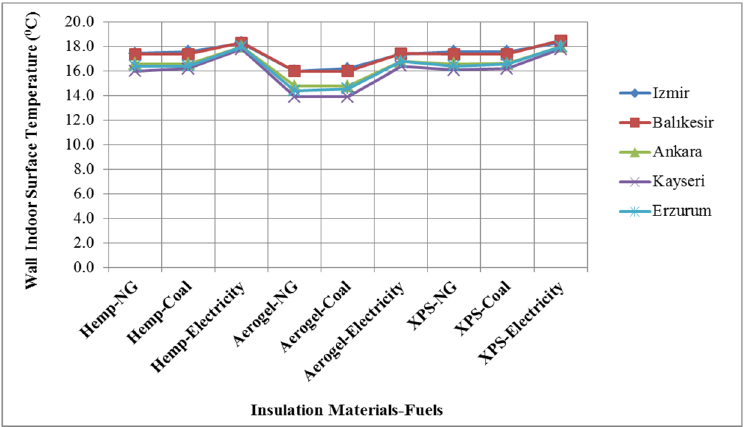
Figure 10. Wall indoor surface temperature values at optimum insulation thickness due to different energy sources and insulation materials.